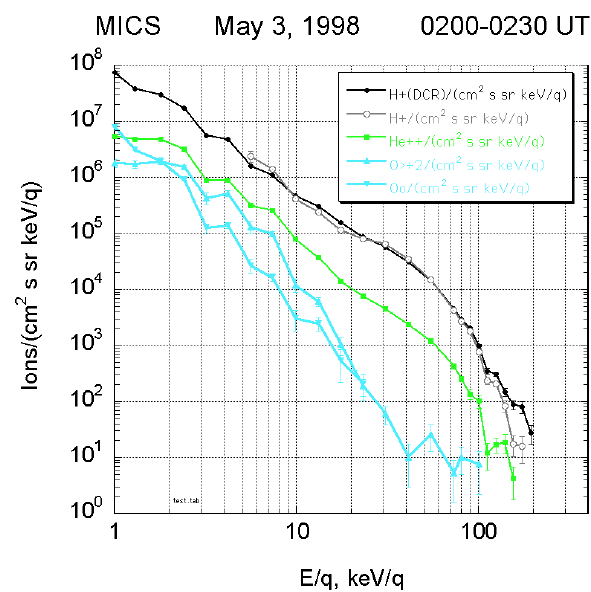
Fig. 10. The energy spectrum of flux versus energy/charge of the four major ion species determined for the interval from 02:00UT to 02:30UT on 3 May 1998.